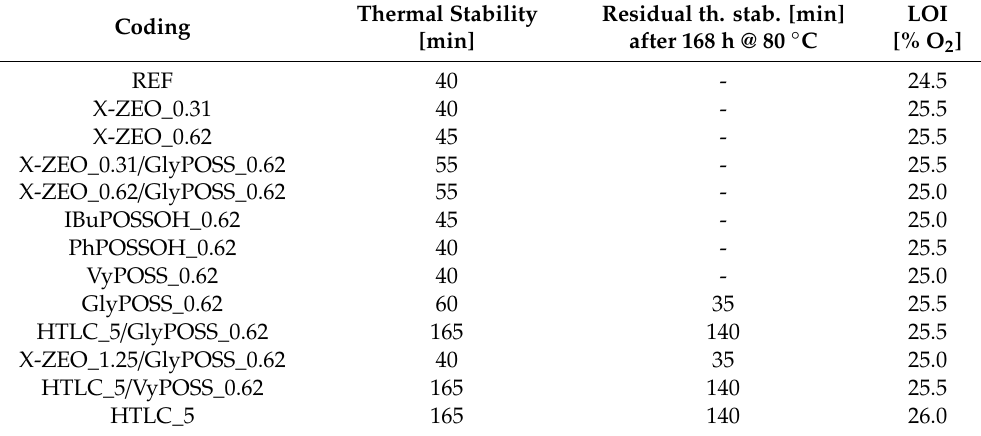
Table 5. HCl evolution according to UNI EN ISO 182-3:2003 test method for P-PVC and nanocomposite formulations, Limiting Oxygen Index (LOI) according to ASTM D 2863.